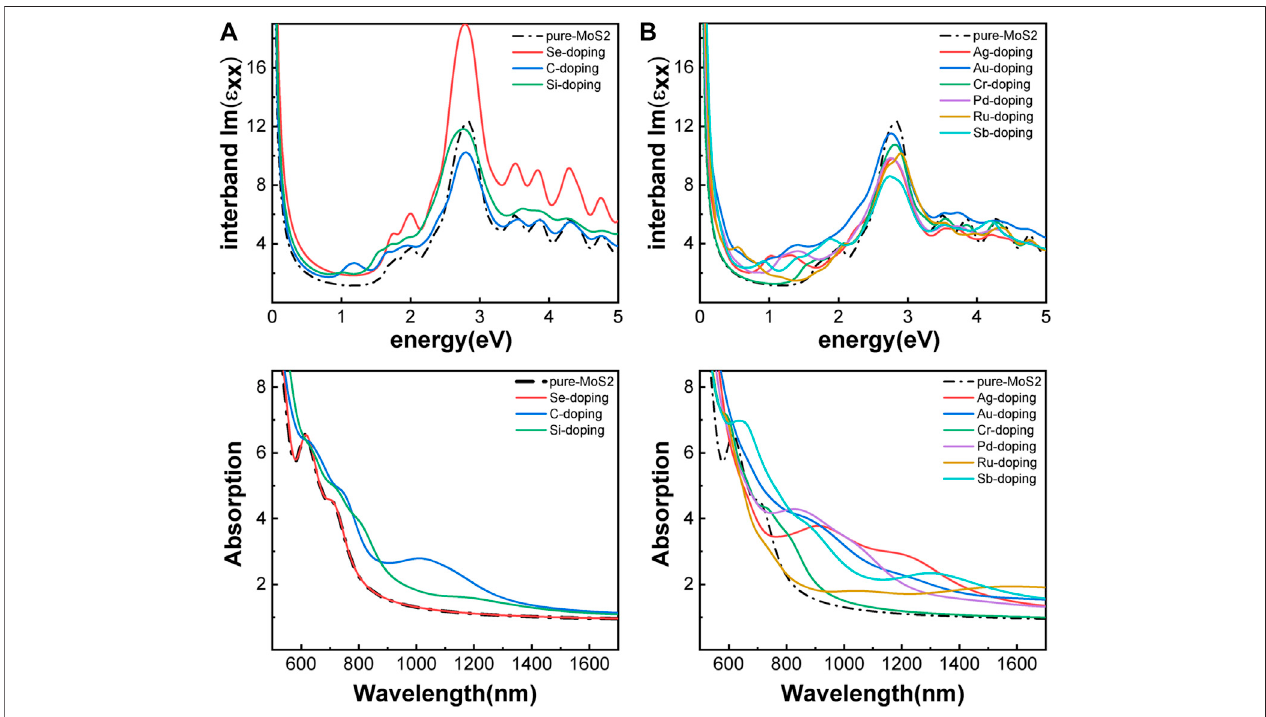
FIGURE 12 | Optical properties of monolayer 2H-MoS 2 after doping with different foreign atoms: (A) the imaginary part of the dynamic dielectric function; (B) absorption spectra. The left column is plotted for the substitution of S atom and the right for Mo atom. The black dotted line is for pure monolayer 2H-MoS 2 . The solid lines of different color refer to different doped atoms as shown in the legends.